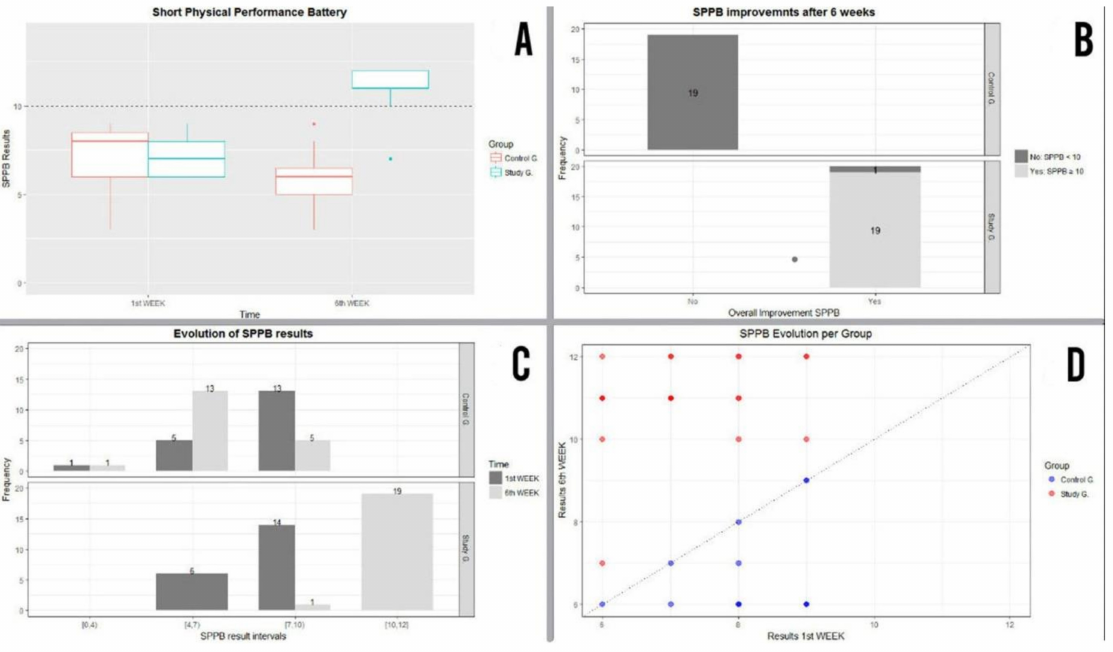
Figure 6. ( A ) Score obtained in the SPPB in week 1 and week 6. ( B ) Percentage frailty and number of participants in control and study group at the end of week 6. ( C ) SPPB score evolution. ( D ) Distribution of SPPB score obtained according to age and